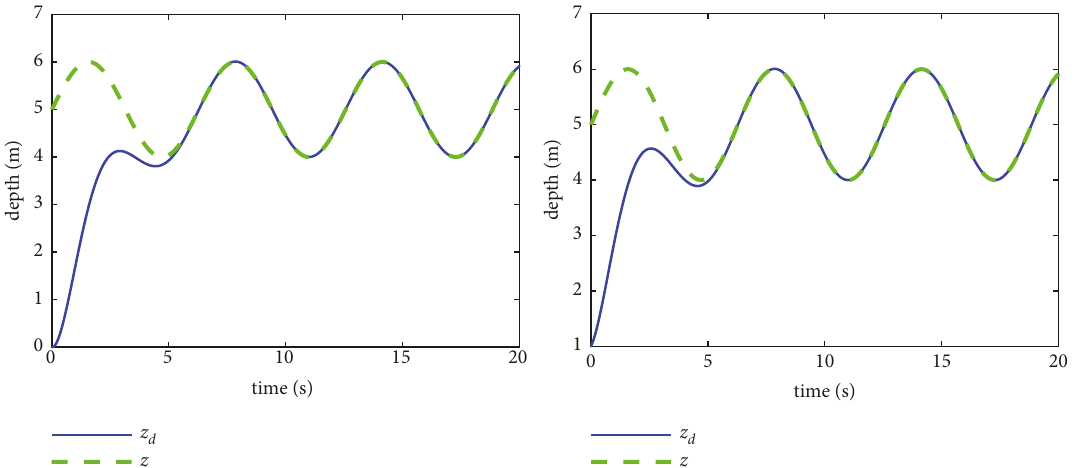
Figure 4: The depth tracking signal 𝑧 and 𝑧 𝑑 .